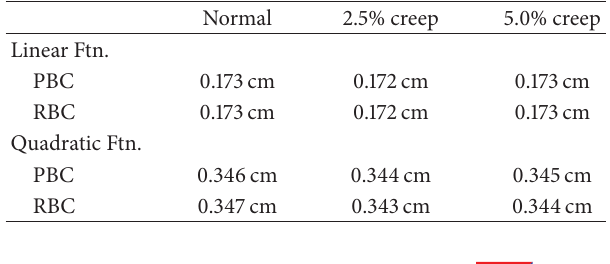
Table 1: Average pitch of triangle elements.